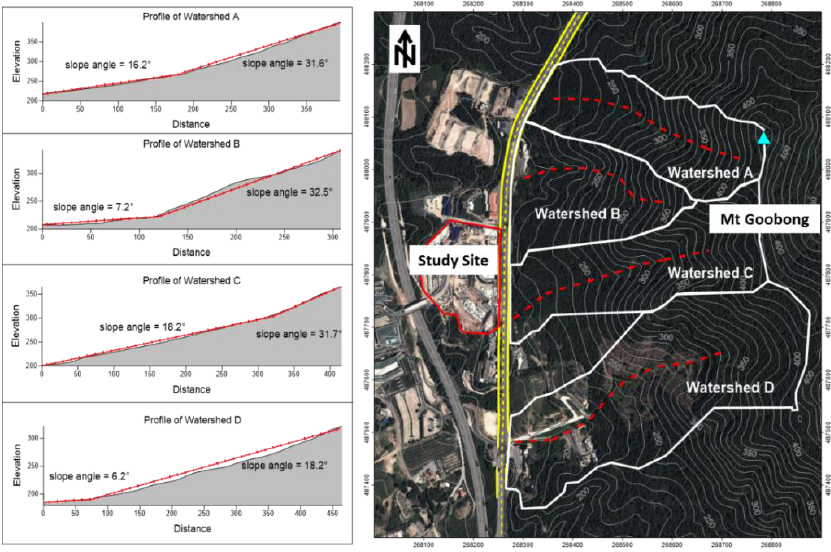
Figure 17. Slope profiles for each watershed.